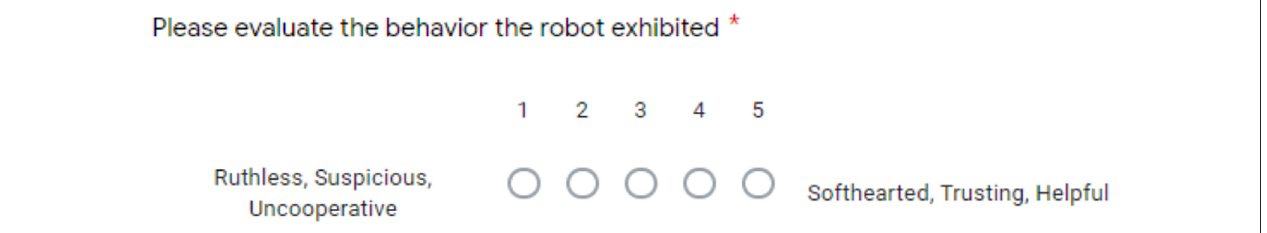
FIGURE 3 | Example of personality question as displayed to the participants in Phase 1 and